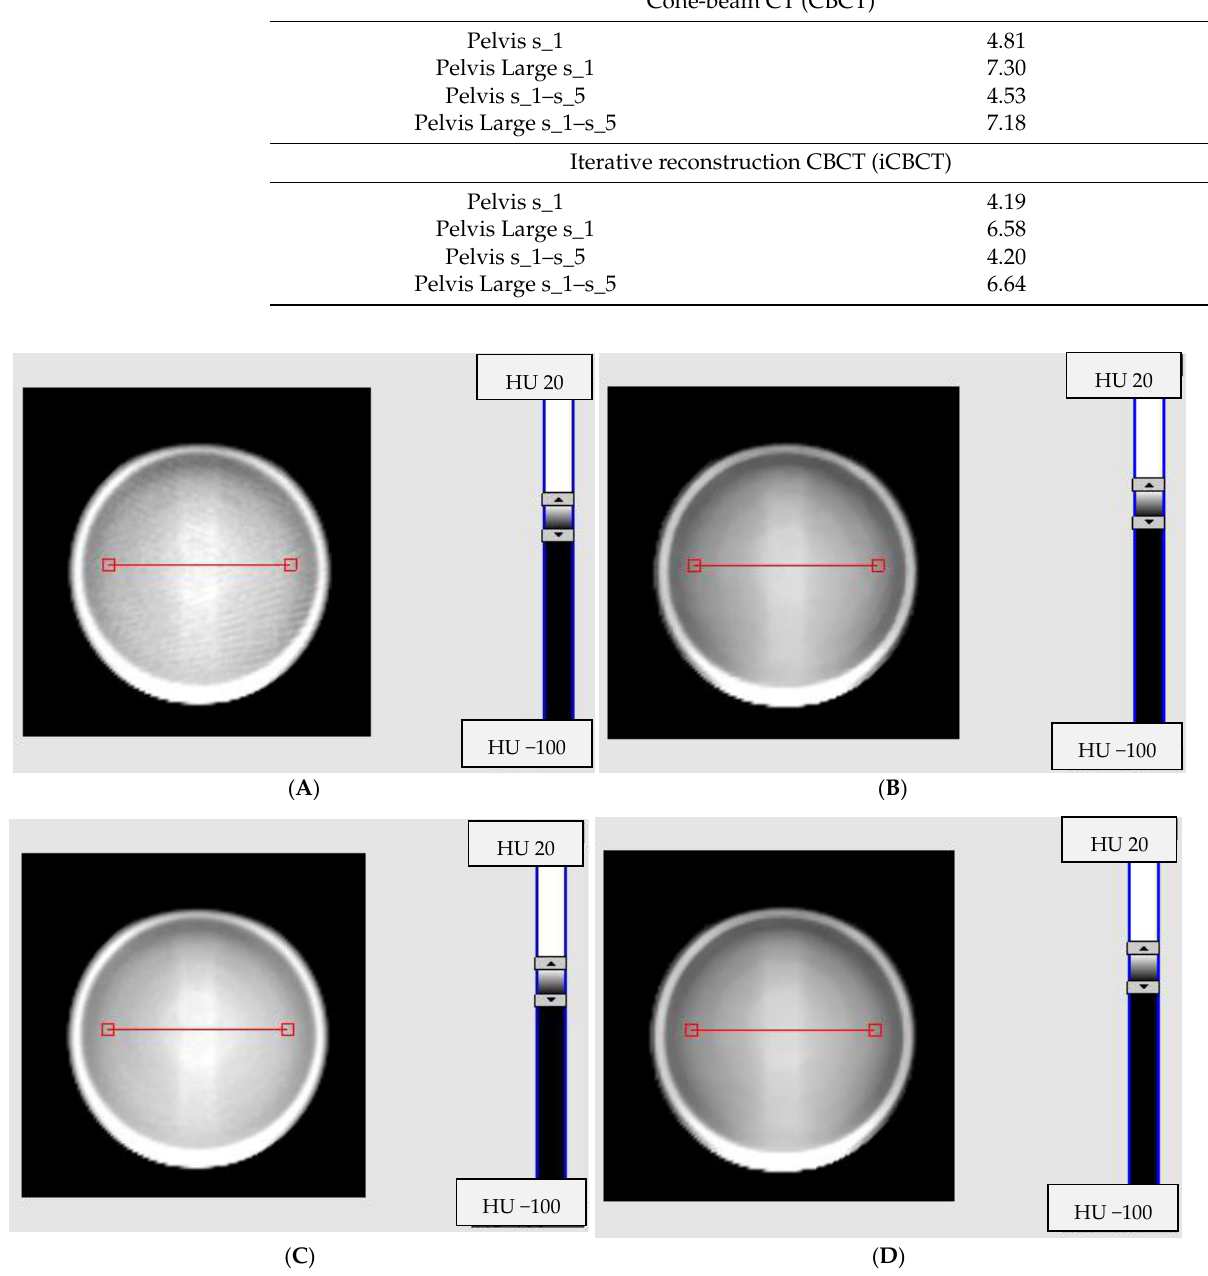
Figure 1. Two-dimensional images (a transversal plane, Z = −1 mm) of irradiated PABIG nx as measured with CBCT and iCBCT (TrueBeam accelerator, Varian). The dosimeter in the PH-6-DD2 container (GeVero Co.): ( A ) is for the CBCT scan, 1 series, ( B ) is for the iCBCT scan, 1 series, ( C ) is for the CBCT with a mean of 5 series and ( D ) is for the iCBCT with a mean of 5 series. Pelvis mode was used for scanning. The red lines in ( A ) − ( D ) indicate the position of profiles presented in Figure 2.